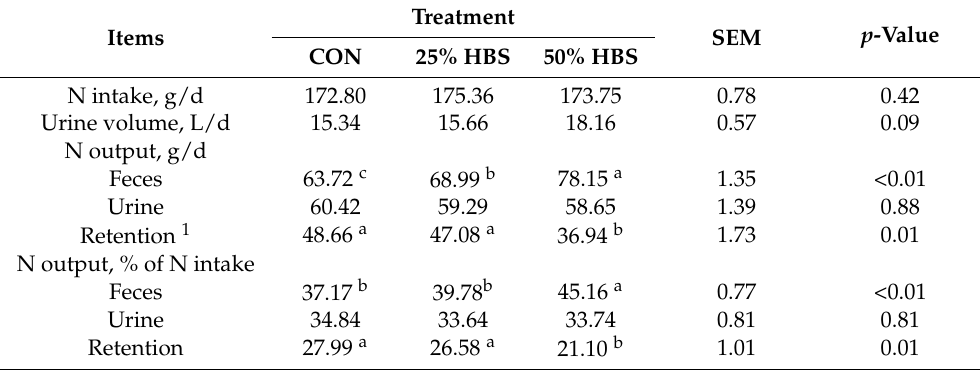
Table 4. Effect of different proportions of hydroponic barley seedlings replacing oat hay on nitrogen metabolism of